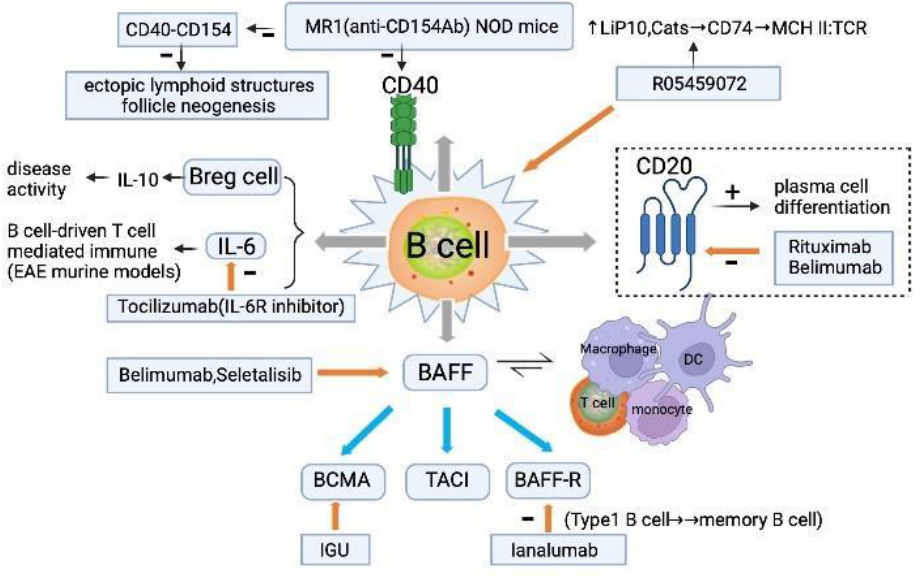
Figure 2. The effect of B cells in the pathologics of pSS.